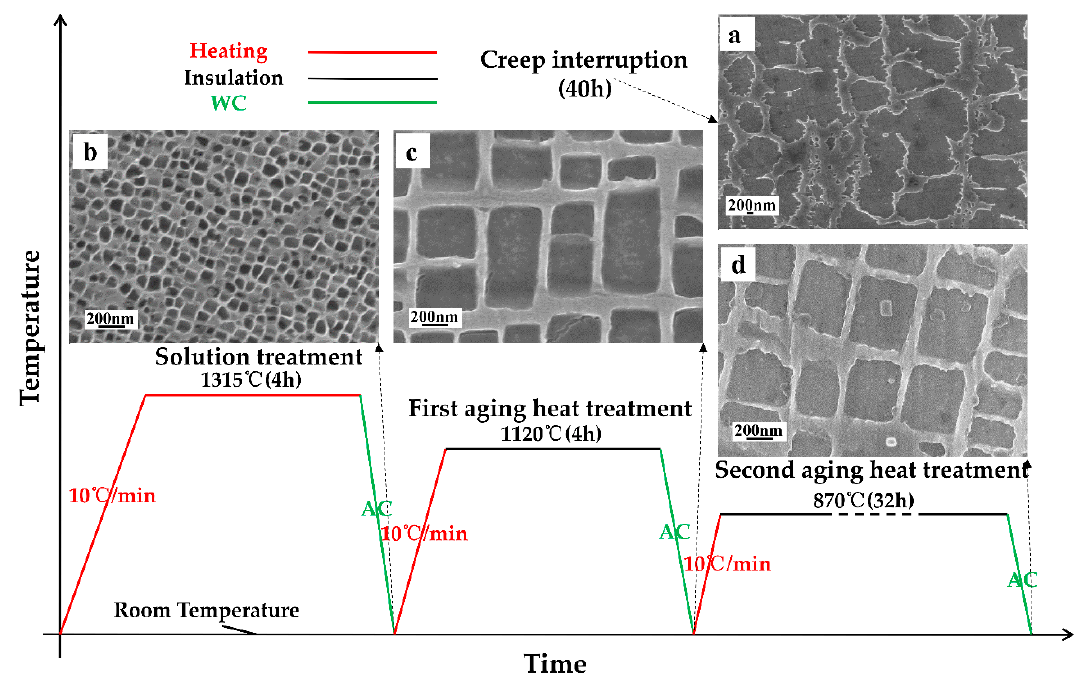
Figure 8. Schematic diagram of recovery heat treatment process and microstructure of test piece with creep interruption (40 h) at each stage of heat treatment. Microstructure after ( a ) the creep interruption test, ( b ) the solution heat treatment, ( c ) the first aging heat treatment and ( d ) the second aging heat treatment.